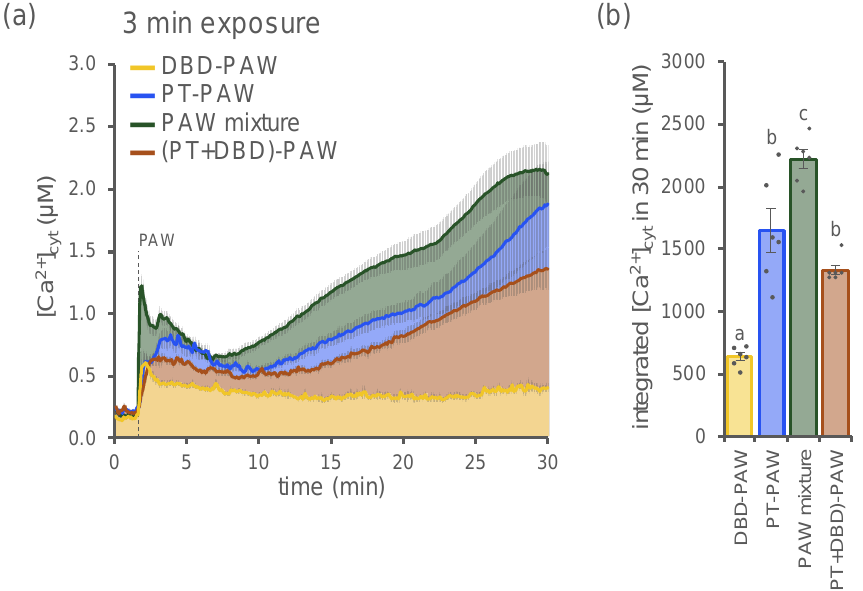
Figure 5. Comparison of the Ca 2+ signatures induced by PAWs generated by different cold plasma sources. [Ca 2+ ] cyt elevations were measured in aequorin-expressing Arabidopsis seedlings after the administration (at 100 s, dashed line) of PAW generated by a DBD (DBD-PAW, yellow, 1:4 dilution), PAW generated by a plasma torch (PT-PAW, blue, 1:4 dilution), a PAW mixture composed of equal volumes (1:1) of both DBD-PAW and PT-PAW (green, 1:2 dilution), a double-treated PAW obtained by sequentially exposing deionized H 2 O to PT and DBD cold plasmas ((PT+DBD)-PAW, brown, 1:4 dilution). All PAWs were obtained by exposing deionized H 2 O to cold plasma for 3 min, with the DBD’s discharge frequency set at 20 kHz. ( a ) Data are the means (solid lines) ± SE (shadings) of the evoked [Ca 2+ ] cyt dynamics in 6 independent seedlings. ( b ) Integrated [Ca 2+ ] cyt dynamics over 30 min. Each dot represents a single biological replicate. Statistical analyses were performed according to Student’s t -test ( p < 0.05), with different letters indicating significant differences.